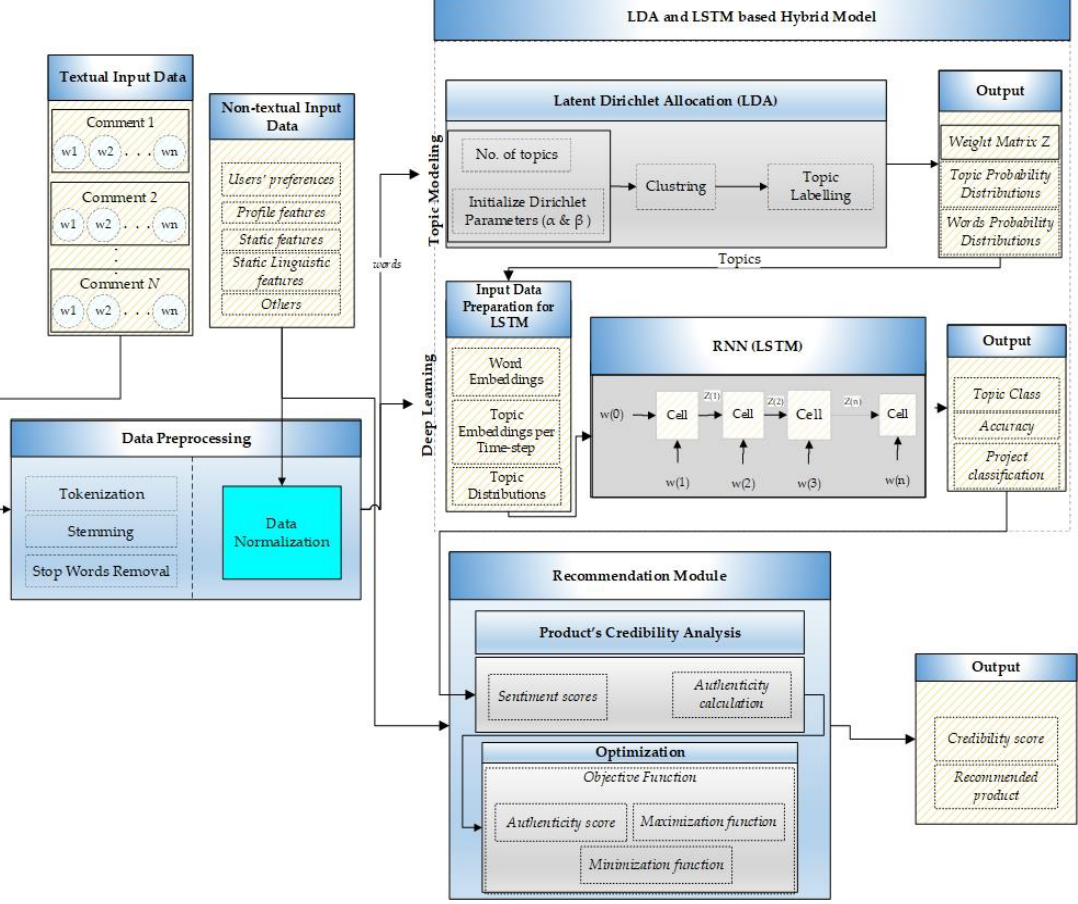
Table 2. Topic classes identified using LDA analysis. Topic Classes